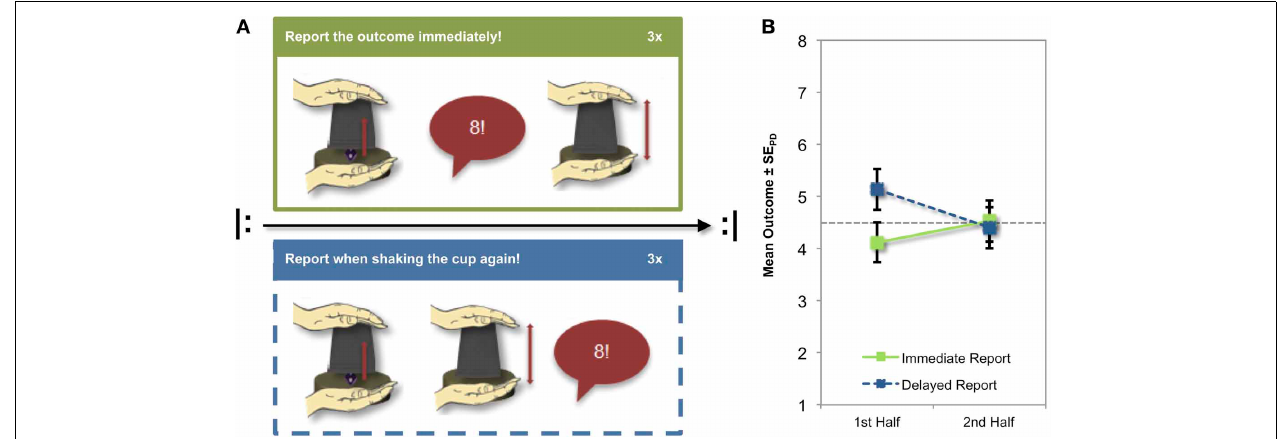
FIGURE 1 | Designand results. (A) Procedureof the immediate(top)and the delayedreport condition(bottom);the experimenterannouncedthecurrent condition,andparticipantsreportedtheoutcomeofthreerollsofaneight-sided die.Bothconditionswererepeatedafterashortbreak. (B) Inthefirsthalfofthe